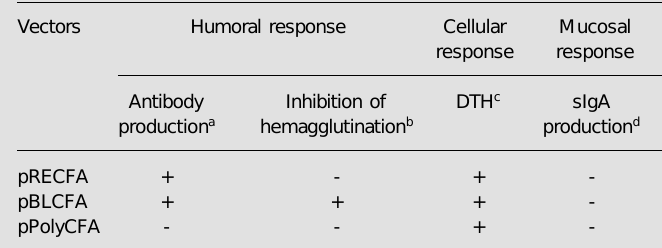
Table 1 - Immune stimulatory properties of the three CFA/I-encoding plas- mids following im inoculation in BALB/c mice. a Evaluated in IgG-ELISA using denatured CFA/I subunits as solid-phase bound antigen. b Evaluated by the ability to block the hemagglutination properties of CFA/I fimbriae expressed by ETEC strain 258909-3 (CFA/I, O128:H?, ST/LT). c Evaluated by footpad swelling or lymph node weights of mice immunized with the DNA vaccines and tested with purified CFA/I protein. d Presence of IgA determined in CFA/I-specific IgA-ELISA using fecal extracts and small intestine homogenates. DTH, Delayed-type